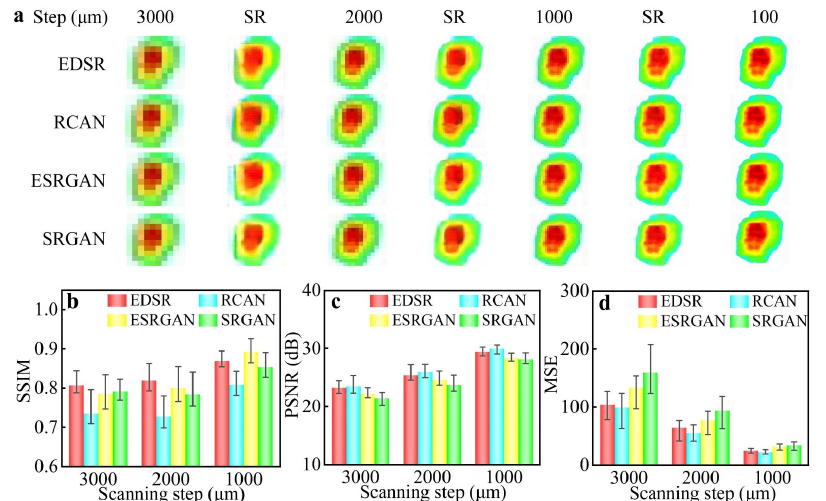
Figure 4. ( a ) THz images with different scanning steps and SR reconstructed images using different algorithms. ( b – d ) SSIM, PSNR, and MSE of the SR reconstructed images.